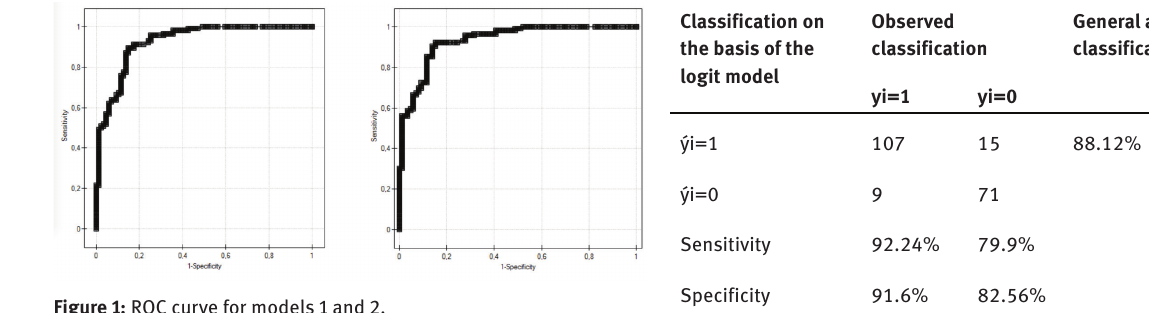
Figure 1: ROC curve for models 1 and 2.